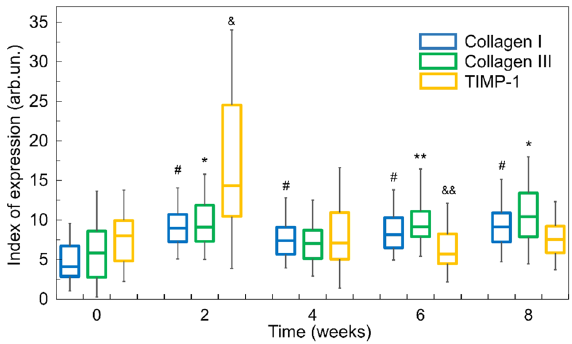
Figure 1. Expression indexes of collagen I, collagen III and TIMP-1 during PAH progression. Statistical difference: # p < 0.001 for collagen I; * p < 0.001 and ** p < 0.01 for collagen III; & p < 0.001 and && p < 0.01 for TIMP-1 as compared with corresponding control